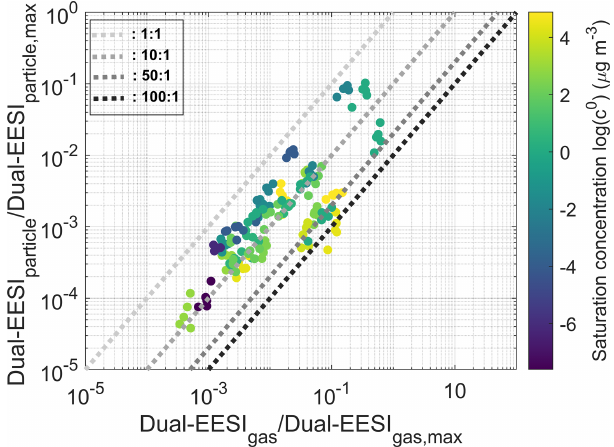
Figure 7. Relative gas-to-particle sensitivity response of the Dual- EESI. The change (decrease) in gas-phase signal and change (in- crease) in particle-phase signal from different molecules (Table S4) are shown on a logarithmic scale due to the 2–3 orders of magni- tudes relative ionization efficiency (RIE) variability range among the molecules for each phase. The 1 : 1, 10 : 1, 50 : 1 and 100 : 1 dotted lines are added for visualization of the gas-to-particle-phase sensitivity response. The particle-phase measurements were cor- rected for size-dependent sensitivity as shown in Fig. S22. The data points are color scaled by their estimated saturation vapor concen- tration (Donahue et al.,